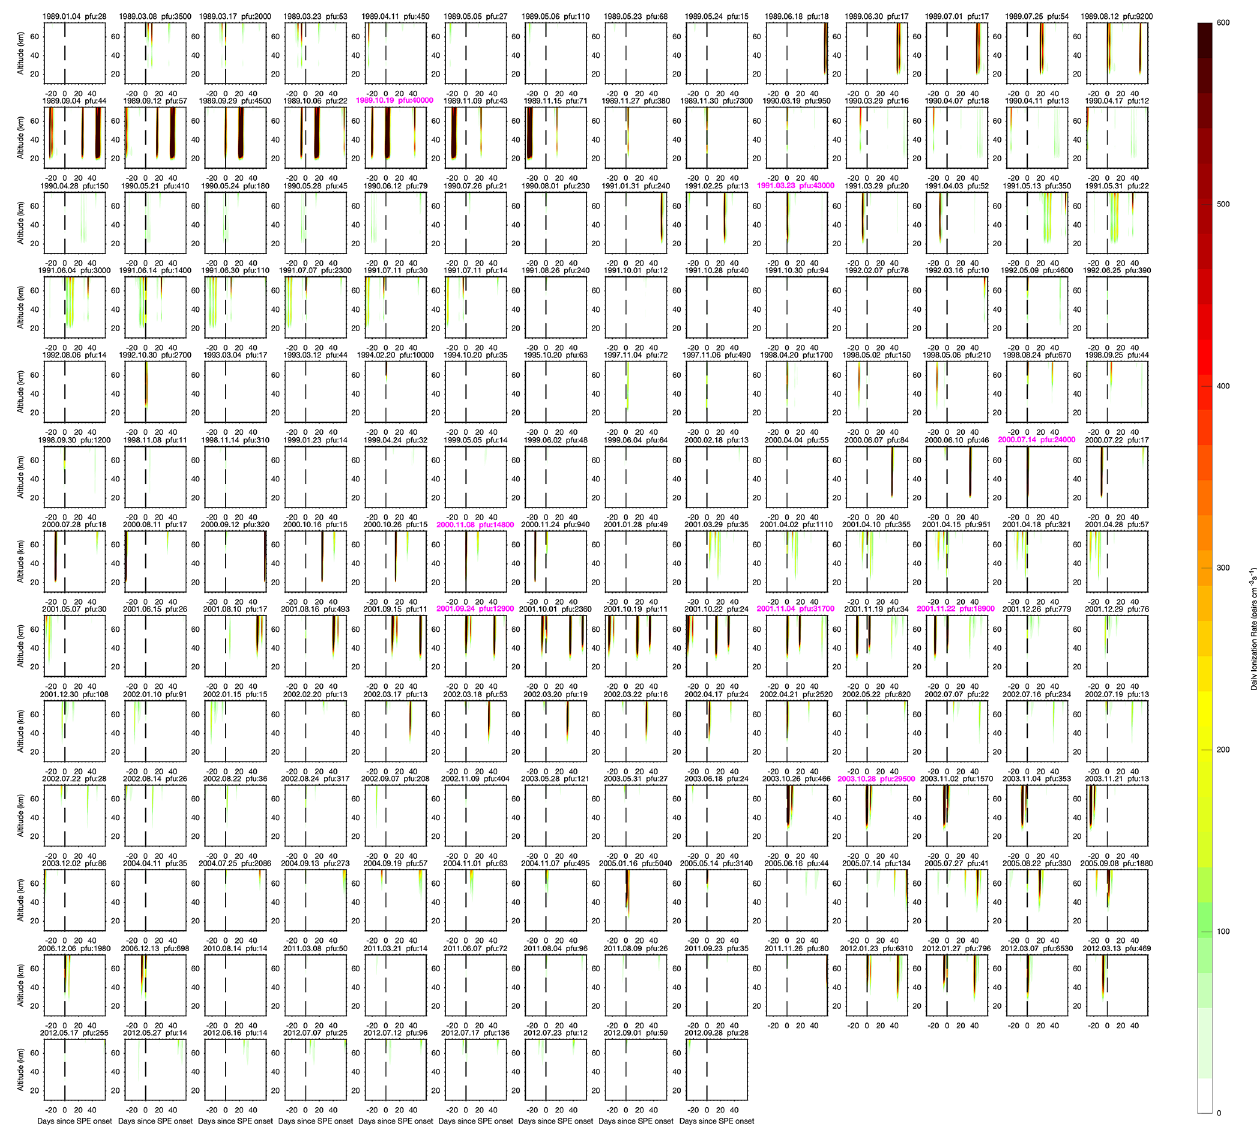
Figure A4. Daily averaged ionization rate along with altitude at 30d before and 60d after individual SPEs since 1989.